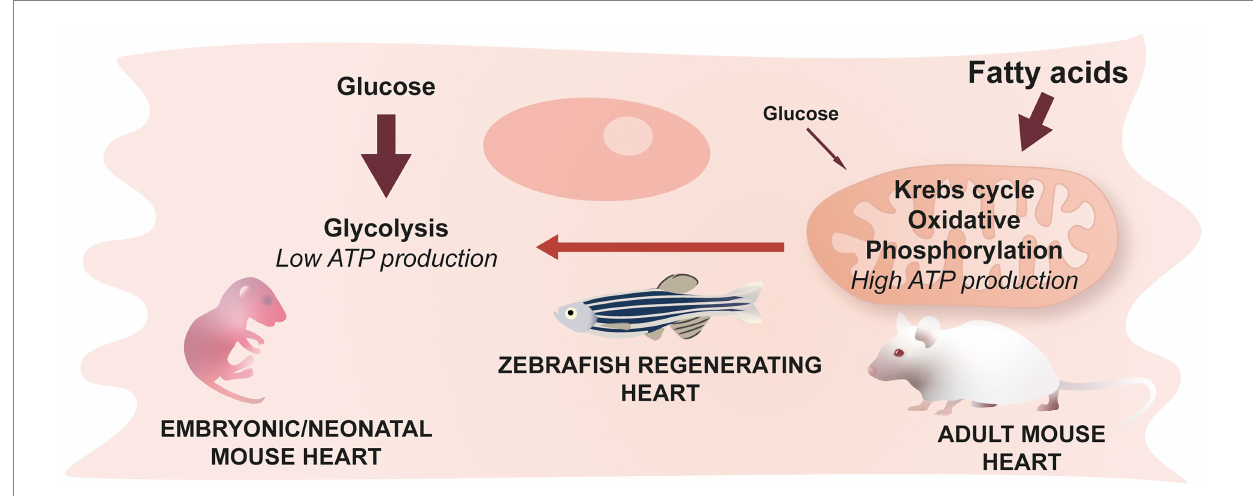
FIGURE 5 Cardiomyocyte metabolism & cardiac regeneration. Neonatal mice predominantly use glucose to generate energy while the main source of energy for adult mice comes from fatty acids and their oxidation. This switch occurring during the early stages of life is irreversible in mammals. Zebrafish cardiomyocytes, however, are able to revert back to a glucose-based metabolism during